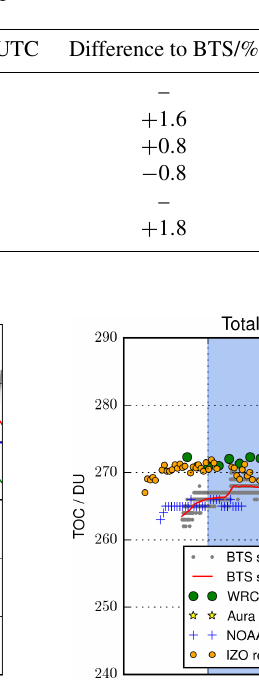
Table 2. Comparison of the BTS-retrieved TOC values to other instrument values measured during the ATMOZ campaign. The data have been calculated based on measurements performed on 20 September 2016 between 09:00 and 11:00UTC, shown in Fig. 8. For the comparison to the OMI data the average of the BTS TOC values measured between 12:30 and 13:00UTC has been calculated. The SD of the averaged TOC values shows the dispersion of TOC values during that time period.